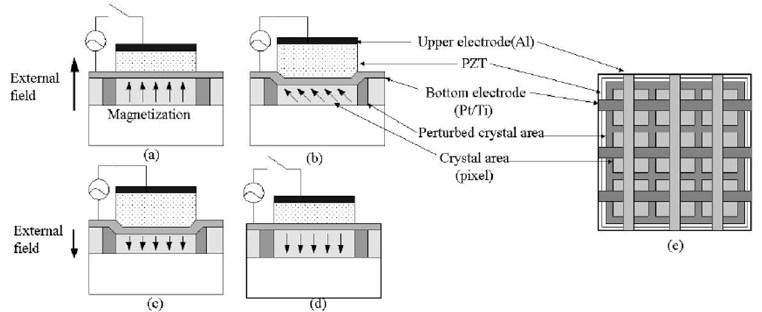
Figure 23. Schematics of PZT-driven magneto-optic spatial light modulator (MOSLM) and the switching mechanism of magnetization in the bismuth-substituted yttrium / iron garnet (Bi:YIG) layer. ( a – d ) Cross-sectional view and ( e ) top view from the upper electrode side. Step-by-step switching mechanism of magnetization is schematically shown in ( a – d ) [56]. © Copyright 2007, Cambridge University Press.